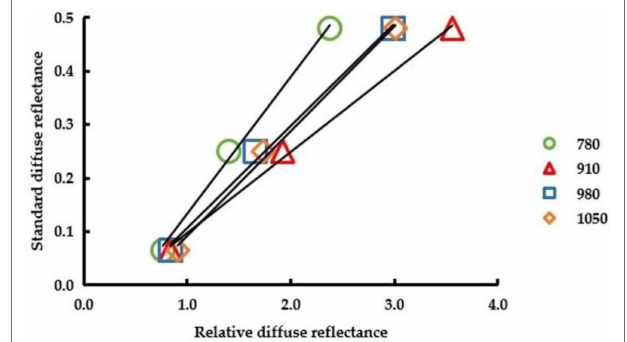
FIGURE 16 | Diffuse reflectance correction of the PSPMWG.